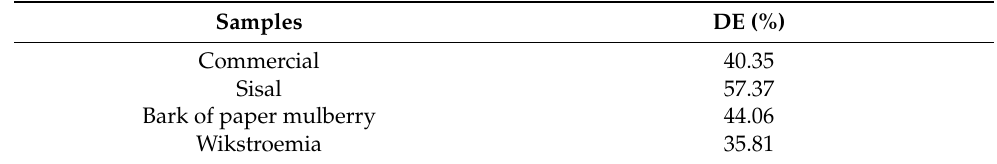
Table 1. DE of different pectin types.